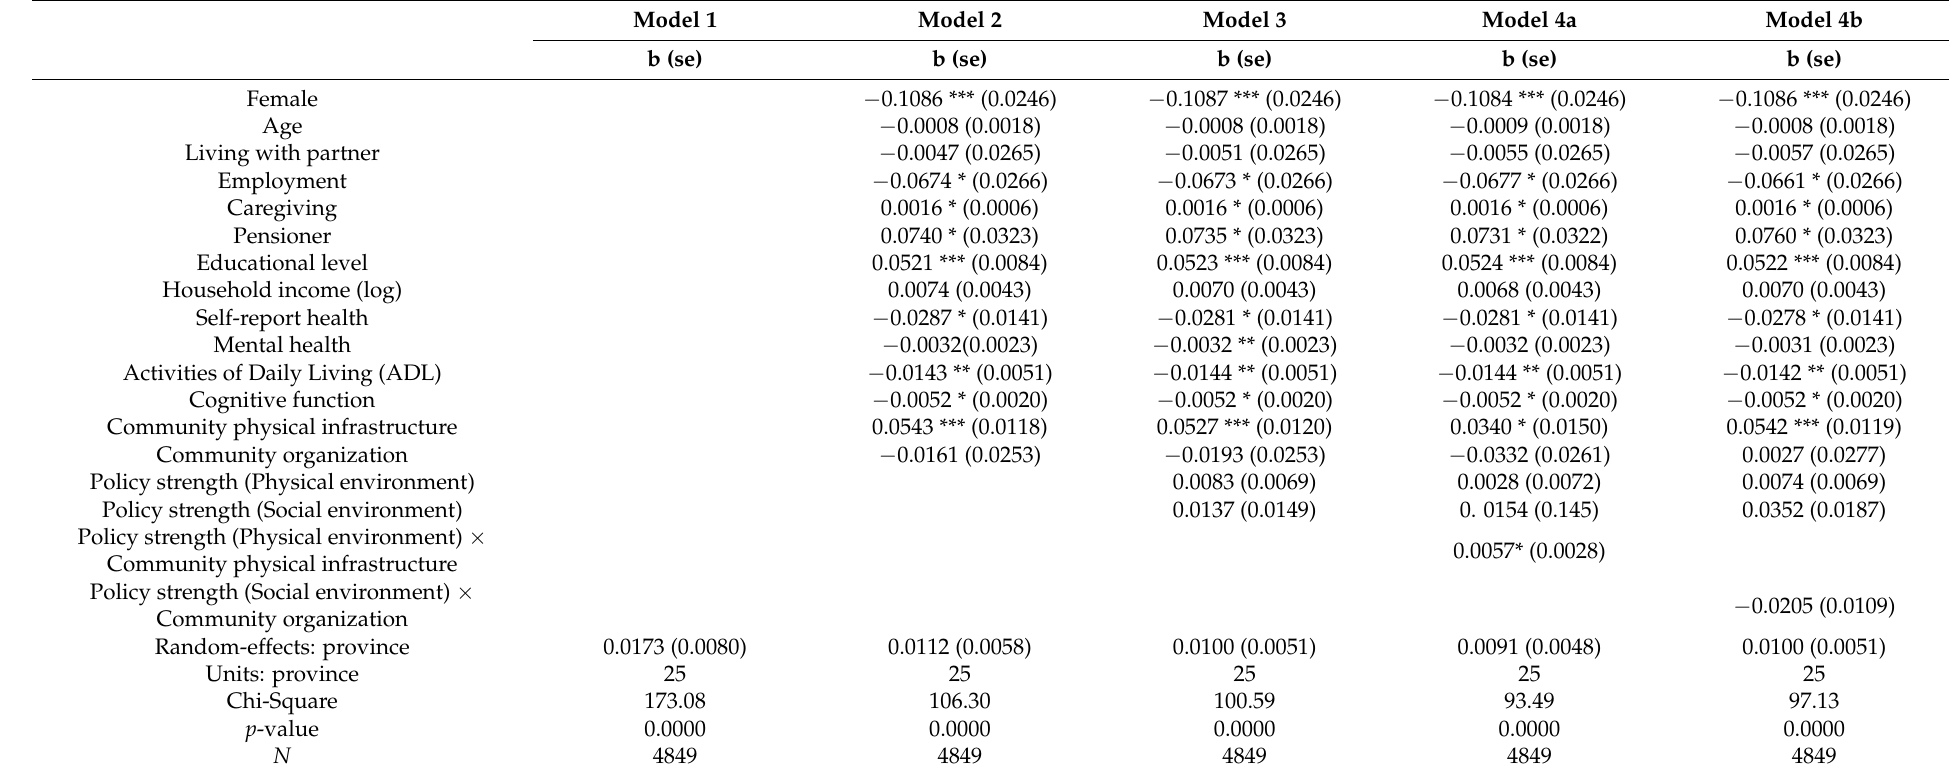
Table 3. Results of Multilevel Linear Models for the Social Participation Score of Rural Older Adults in